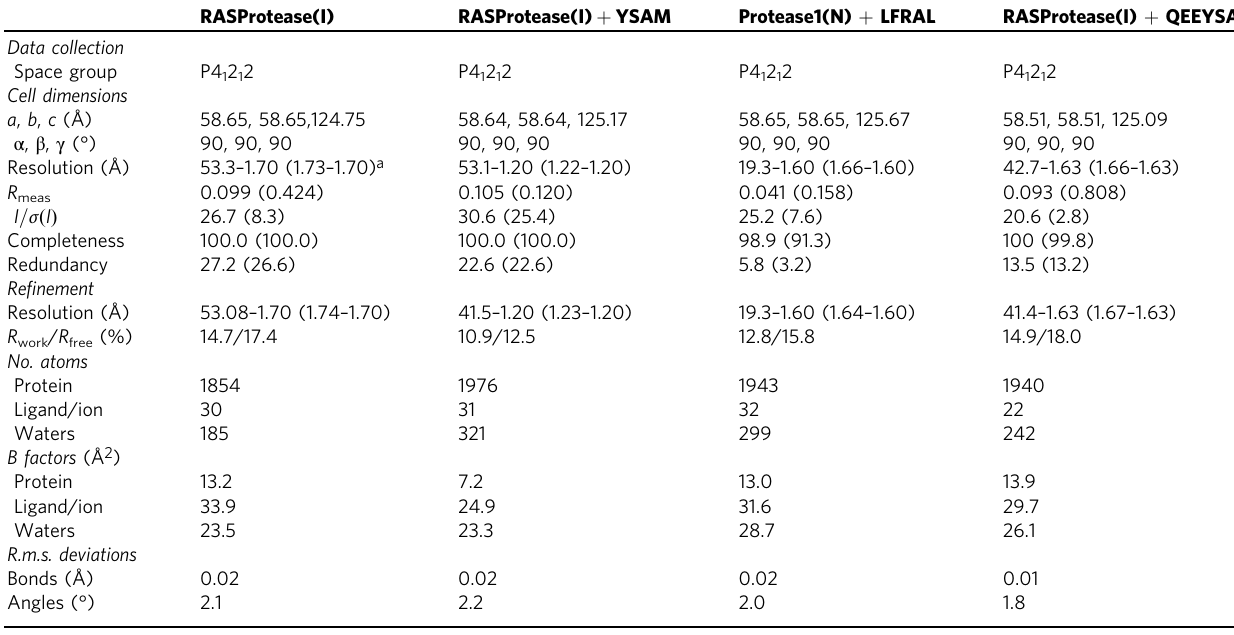
Table 1 Data collection and re fi nement statistics (molecular